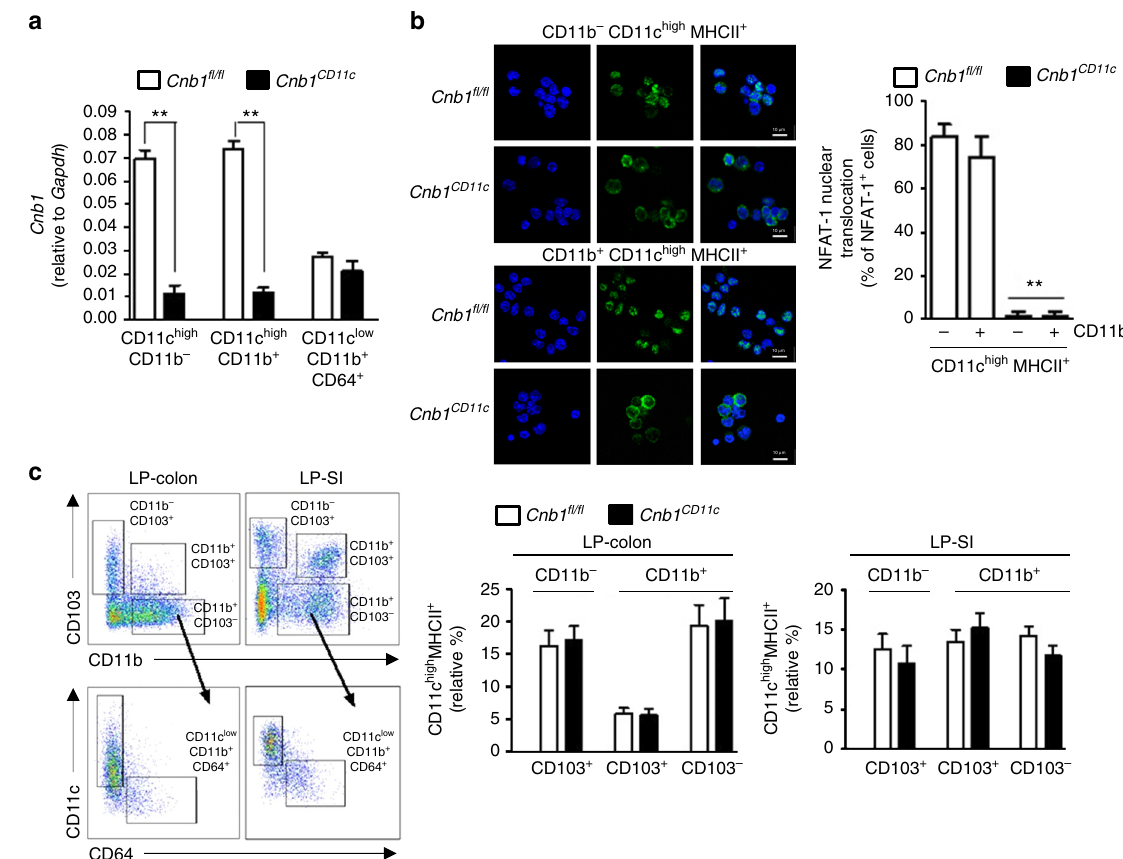
Fig. 2 Cnb1 deletion in CD11c high MHCII + cells abrogates NFAT-1 nuclear translocation. a Cnb1 mRNA levels in DCs (CD11c high MHCII + CD11b + , CD11c high MHCII + CD11b − ) and macrophages (CD11c low MHCII + CD11b + CD64 + ) isolated from the LP-colon of Cnb1 CD11c and Cnb1 fl / fl mice, measured by qRT-PCR. Data represent the means± standard error of three experiments ( n = 3 mice/experiment). ** P < 0.01. b Confocal microscopy analysis of NFAT-1 nuclear translocation in CD11c high MHCII + cells (CD11b + and CD11b − ) from the MLN of Cnb1 CD11c and Cnb1 fl / fl mice after thapsigargin stimulation for 30 min. Data represent the means± standard error of two experiments ( n = 3 mice/experiment). ** P < 0.01. Scale bar 10 μ m. c Representative fl ow cytometric analysis of intestinal LP mononuclear myeloid CD11c + cells evaluated by CD11c, CD103, CD11b, and CD64 expression. Four myeloid cell subsets were identi fi ed: three DC populations, CD11c high CD103 + , CD11c high CD103 + CD11b + , CD11c high CD103 − CD11b + and one CD11c low CD103 − CD11b + macrophage population. The macrophage population was identi fi ed based on the expression of CD64 within the CD11c low CD103 − CD11b + population (CD11c low CD64 + ). The frequency of the four different myeloid subsets in LP-colon (left) and LP-SI (right) of Cnb1 CD11c and Cnb1 fl / fl mice is shown. Data represent the means ± standard error of three experiments ( n = 2 – 3 mice/group per experiment, aged 8 – 12 weeks). LP lamina propria, SI small